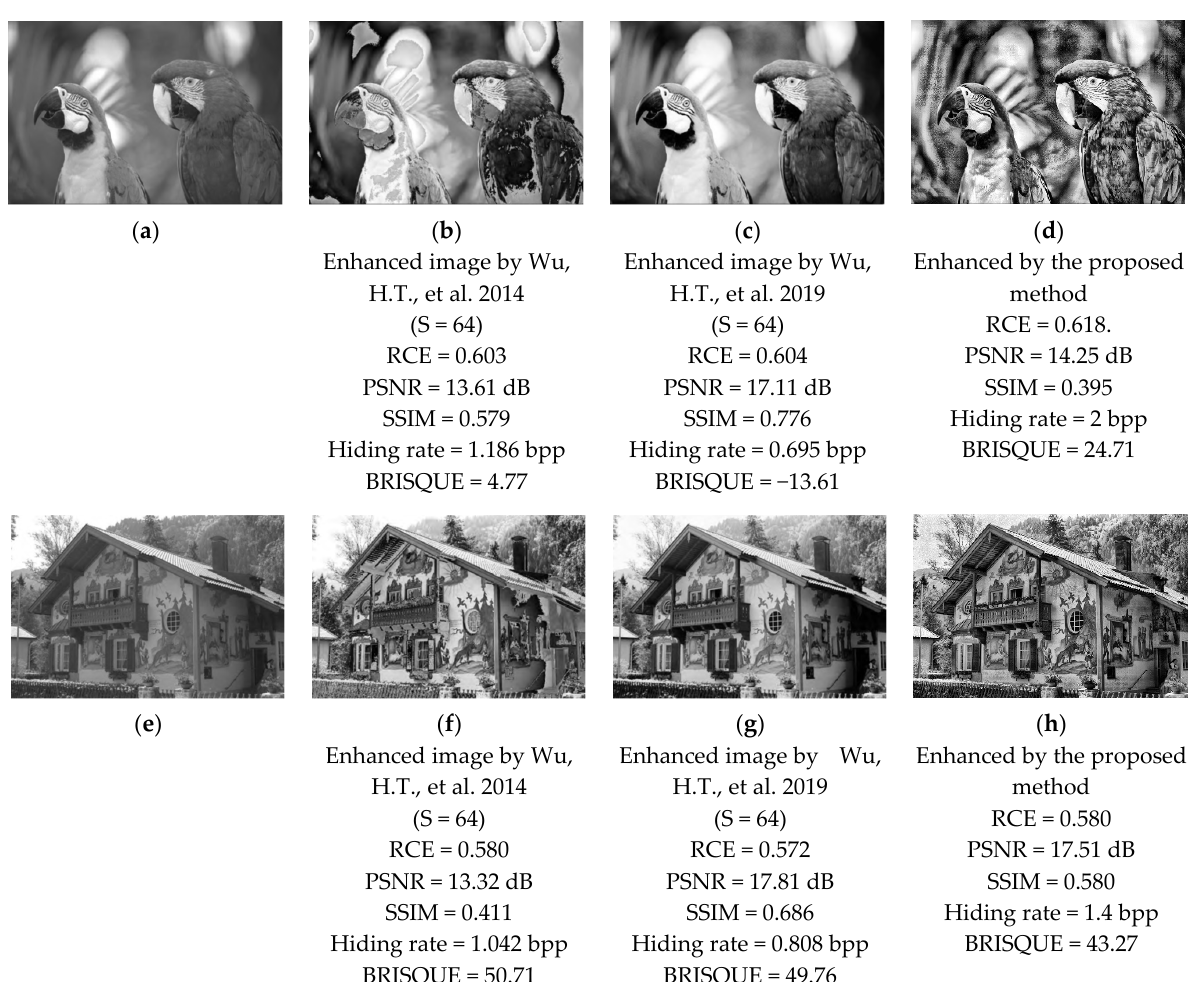
Figure 18. Zoomed parts of some original images ( left column ), enhanced images obtained by algo- rithm in [31] ( centered column ), and by our proposal ( right column ). 5. Discussion Many RDH-CE algorithms attempt to increase hiding rate and image contrast simul- taneously. On the other hand, the proposed approach attempts to increase the hiding rate and decrease pixel modification (distortion). Afterward, contrast increment is indirectly achieved. The result is that we conceal part of the information at each iteration while de- laying the quality drop; namely, we can embed more information with less distortion to the image. To prove the previous statement, Tables 4–8 show that for a similar hiding rate,